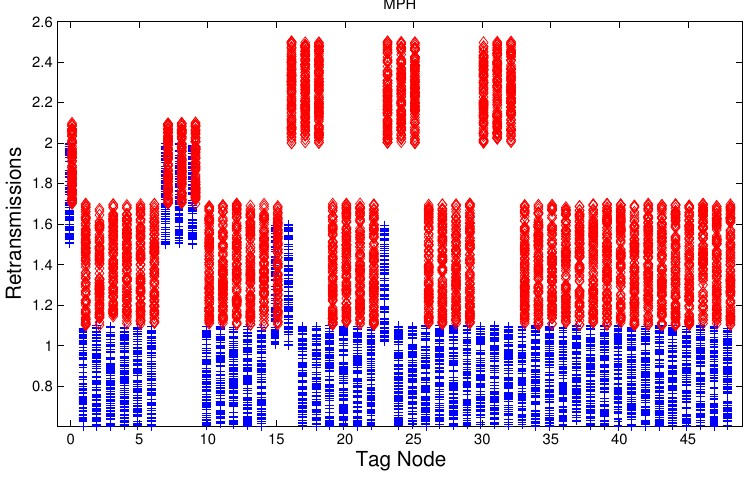
Figure 12. Average number of packet re-transmissions of the nodes from Figure 3 for MPH (Multi-Parent Hierarchical) under normal (blue) and jamming (red)